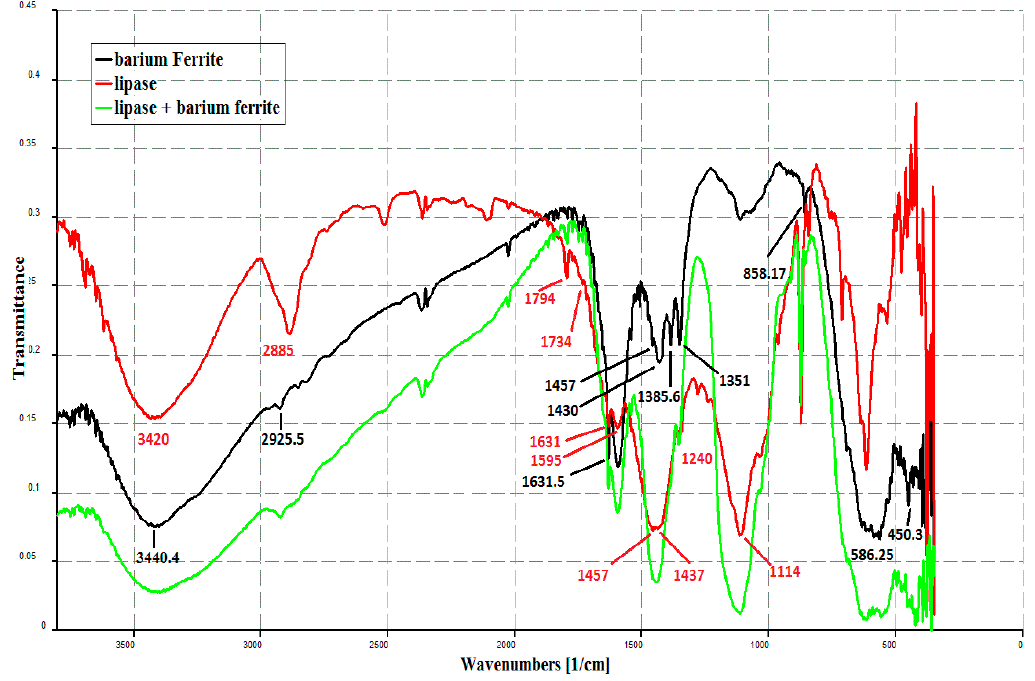
Figure 1. FTIR spectra of: ( a ) free Aspergillus niger ADM110 lipase enzyme; ( b ) Barium ferrite magnetic nanoparticles; ( c ) Immobilized lipase enzyme on barium ferrite magnetic nanoparticles.